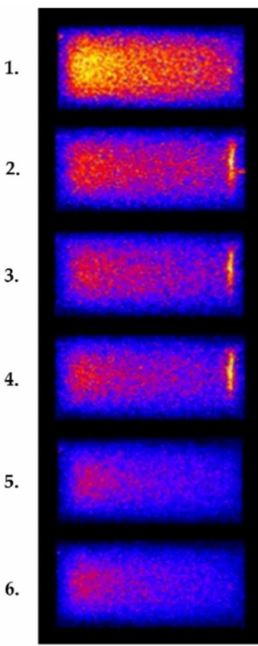
Figure 8. MRI of Core B: ( 1 ) Saturated kerosene state; ( 2 ) after the first cycle of huff-n-puff; ( 3 ) after the second cycle of huff-n-puff; ( 4 ) after the third cycle of huff-n-puff; ( 5 ) after displacing 1 PV; ( 6 ) after displacing 10